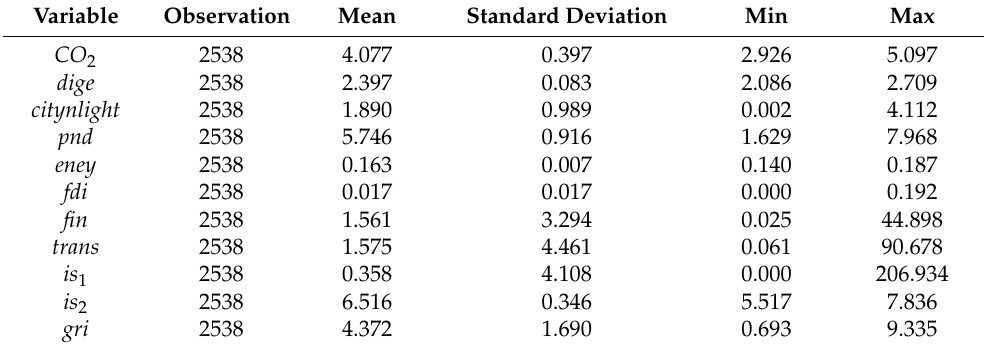
Table 2. Descriptive statistics.